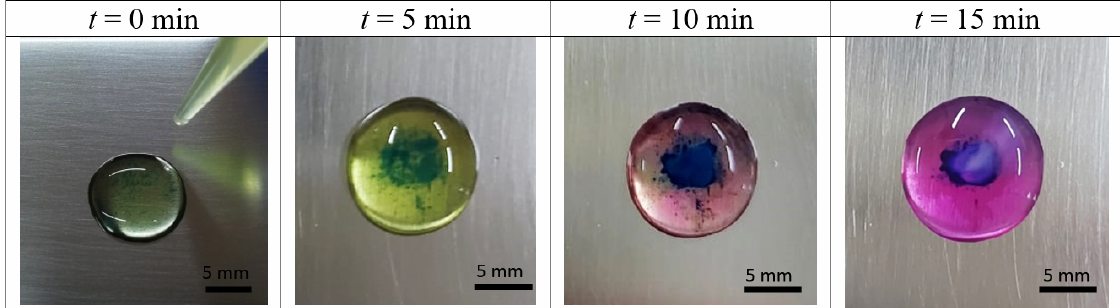
Figure 2. Evolution of the Evans’s drop experiment on an iron surface over 15 min.